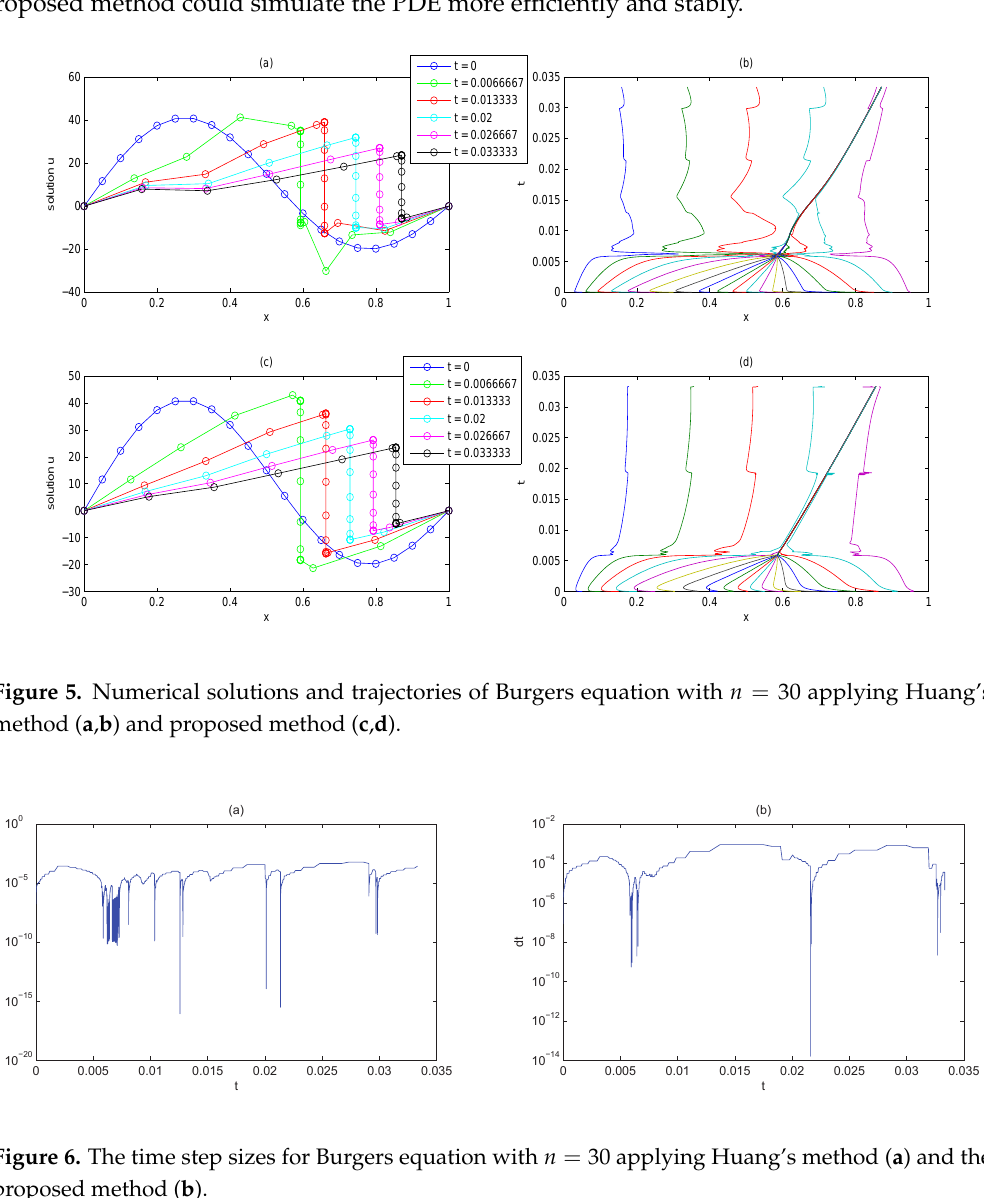
Figure 6. The time step sizes for Burgers equation with n = 30 applying Huang’s method ( a ) and the proposed method ( b